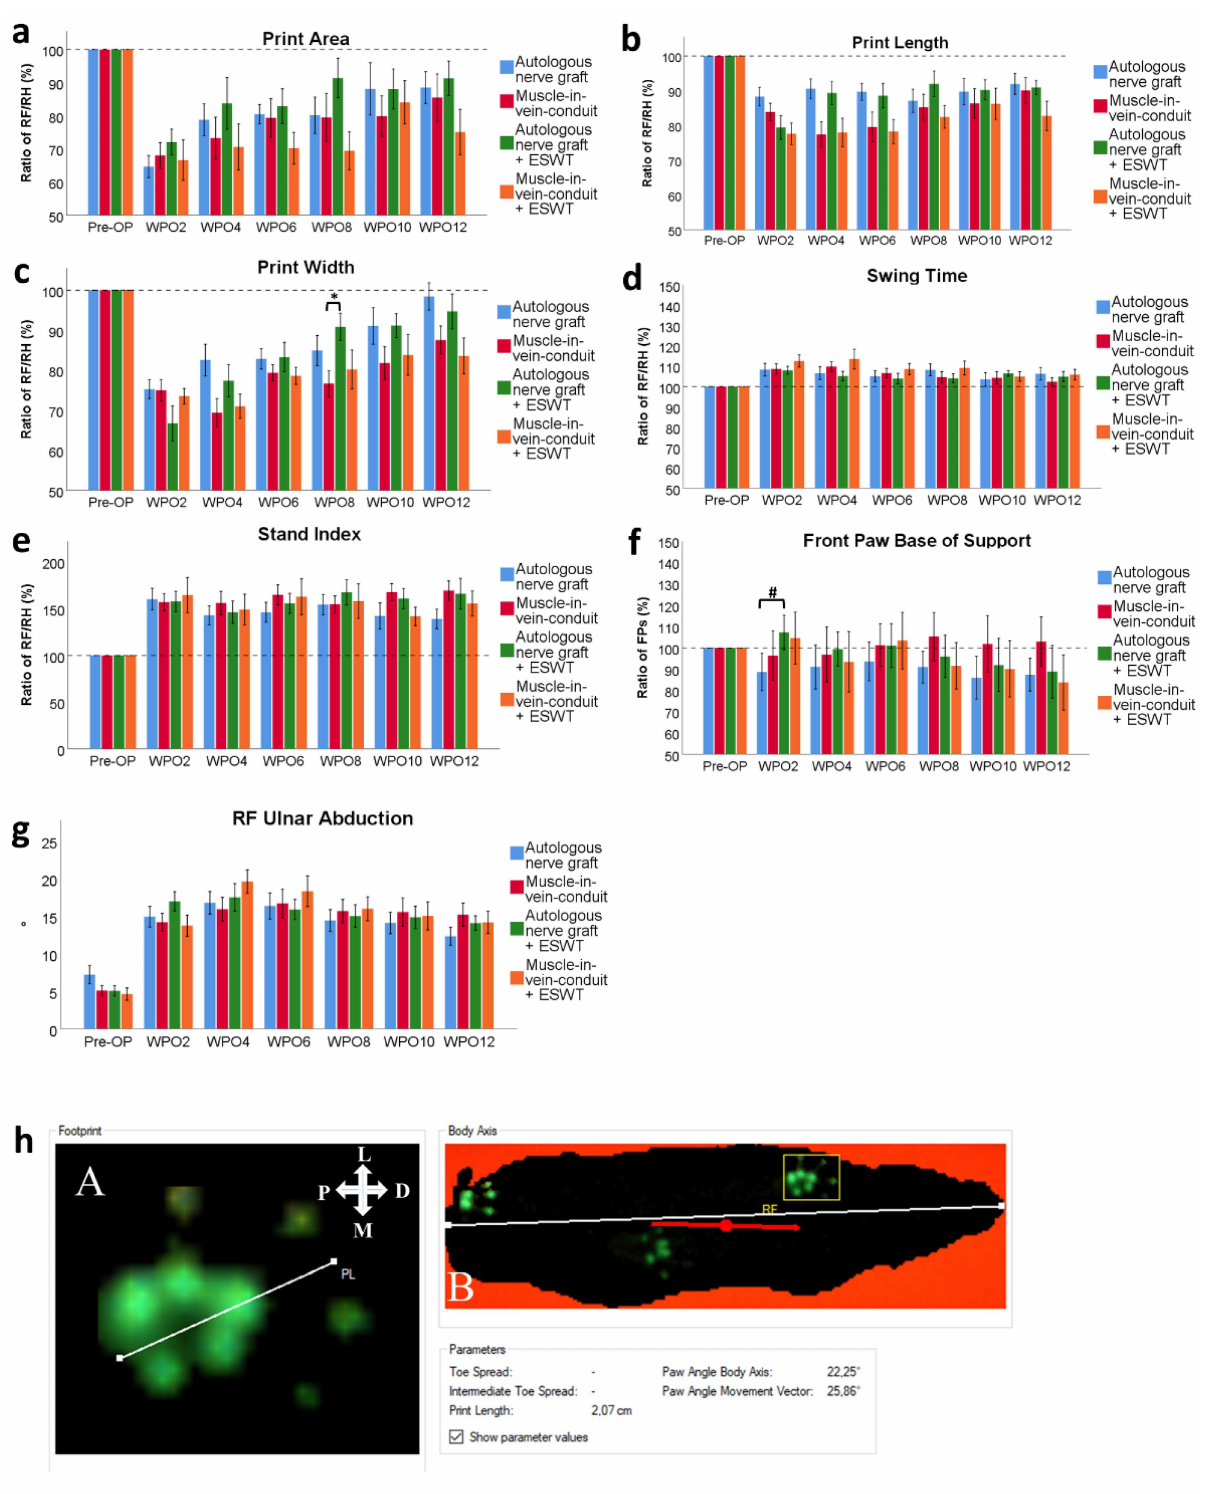
Figure 3. Results of computerized gait analysis via CatWalk XT version 10.6 following resection of a 7 mm segment of the right median nerve and immediate reconstruction with an autologous nerve graft ( n = 13), a muscle-in-vein conduit ( n = 16), an autologous nerve graft + ESWT (autologous nerve graft with postoperative extracorporeal shockwave therapy) ( n = 15) or a muscle-in-vein conduit + ESWT (muscle-in-vein conduit with postoperative extracorporeal shockwave therapy) ( n = 11). The assessed parameters included the paw print area of the right front paw ( a ), the print length ratio